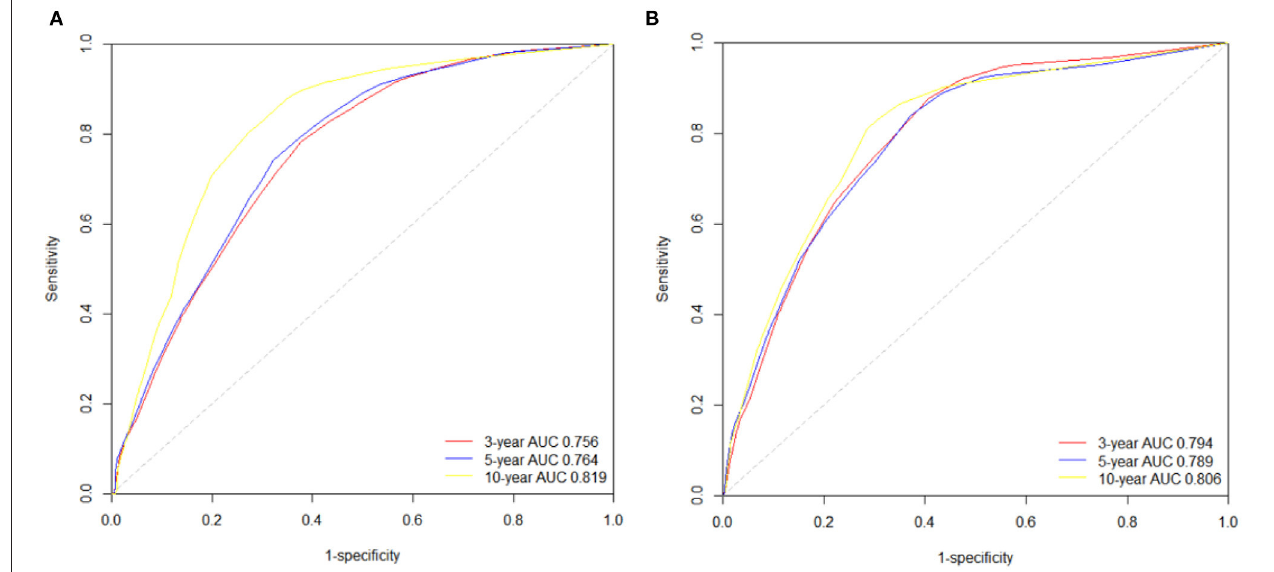
FIGURE 6 | The time-dependent ROC curves of the nomograms predicting 3-,5-, and 10-year (A) OS rates; (B) CSS rates.